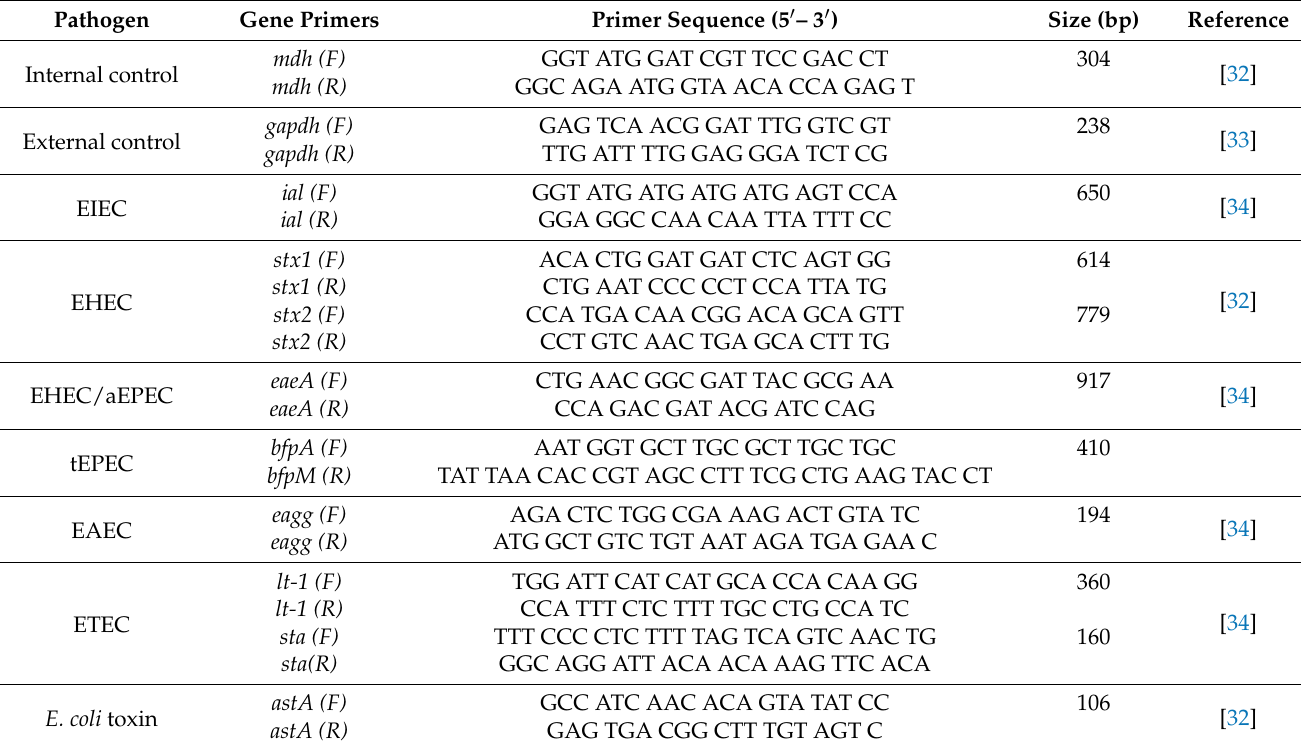
Table 1. Primers used for multiplex PCR in this